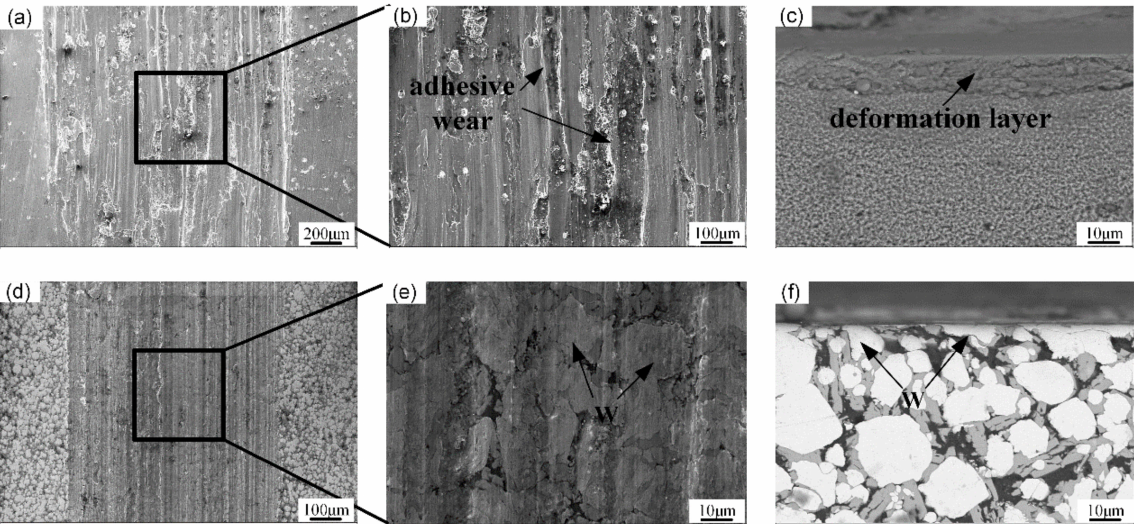
Figure 13. Wear surface ( a , b , d , e ) and cross-sectional view ( c , f ) of 7075 Al alloys ( a – c ) and W/Al layer with a powder feeding rate of 16 g/min ( d – f